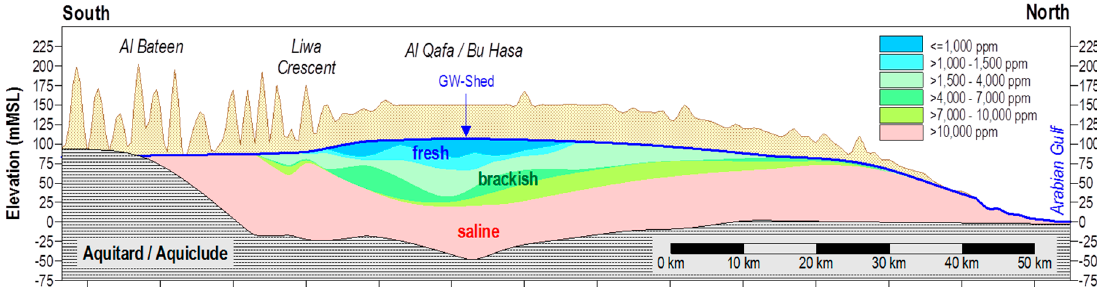
Figure 2. Cross section along red line in Figure 1, showing groundwater salinity distribution and position of groundwater divide where SWSR project. From GTZ-Dornier (with permission): [10].